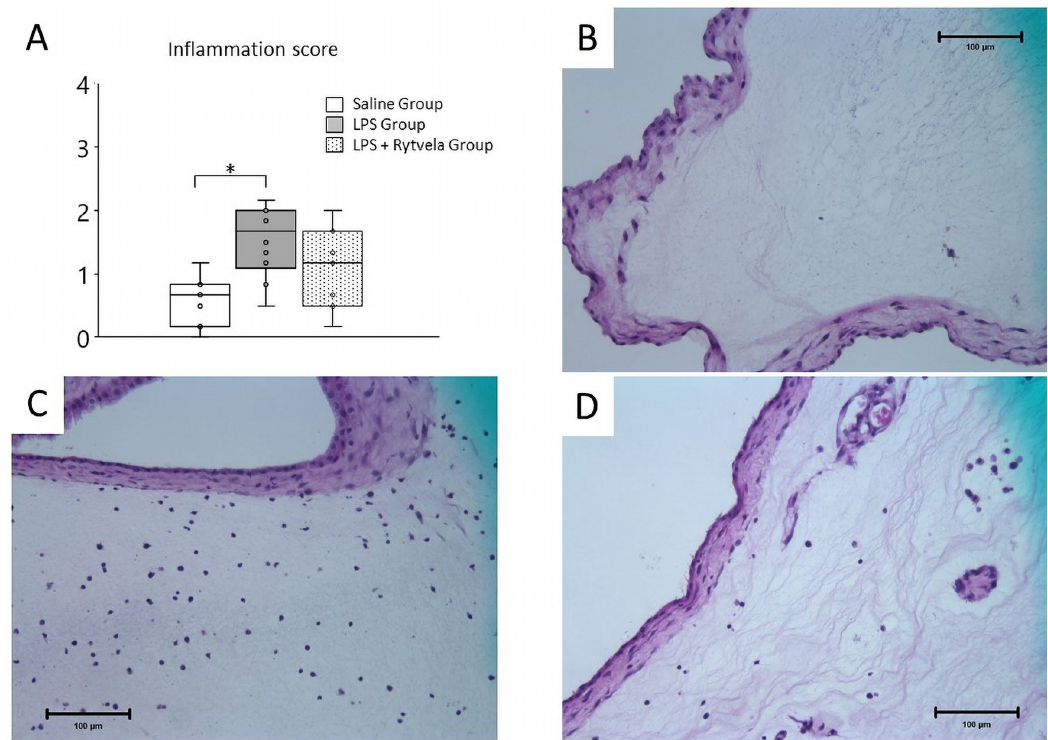
Fig 7. Histological assessment of chorioamnion. A , Plots show median, 25th, and 75th percentile ranges as boxes and 5th to 95th percentiles as error bars. The LPS Group increased inflammation score in chorion-amnion tissue relative to the Saline Group. � p < .05 between the Saline Group and the LPS Group. Representative sections of tissue from B , Saline Group (score = 0); C , LPS Group (score = 2); D , LPS + rytvela Group (score = 1). Scale bar: 100 μ m. n = 7–10 animals/group. LPS, lipopolysaccharide.